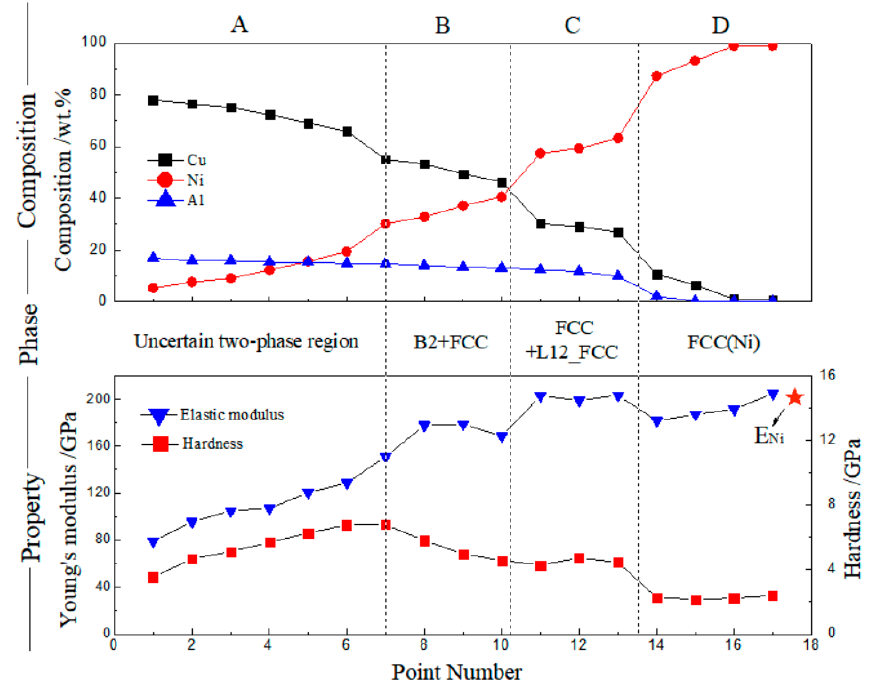
Figure 4. Composition–phase–property relation of the Cu–Ni–Al ternary system, 650 °C × 400 h.